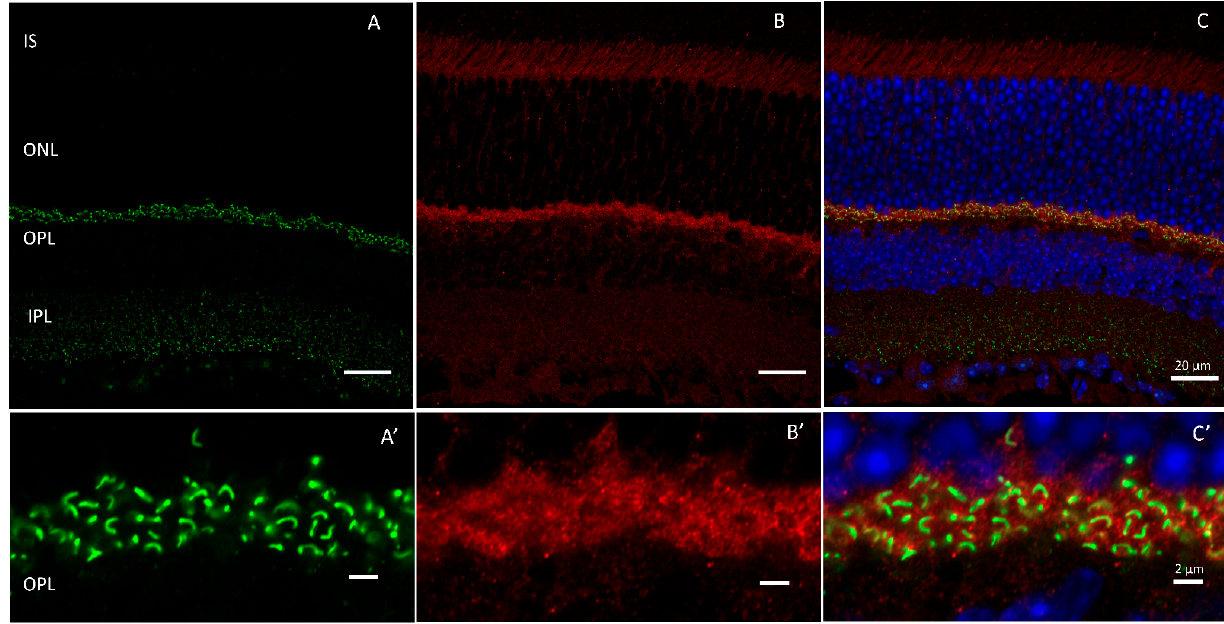
Figure 2. HRG4/Unc119 is expressed in the outer plexiform layer of murine retinas. Immunolabeling of ribbon synapses with ( A ) Ribeye (green) and ( B ) HRG4/Unc119 (red). ( C ) merged. Outer plexiform layer ( A’ ), ( B’ ) and ( C’ ). Scale bar = 20 µm in ( A – C ) and 2 µm in ( A’ – C’ ).